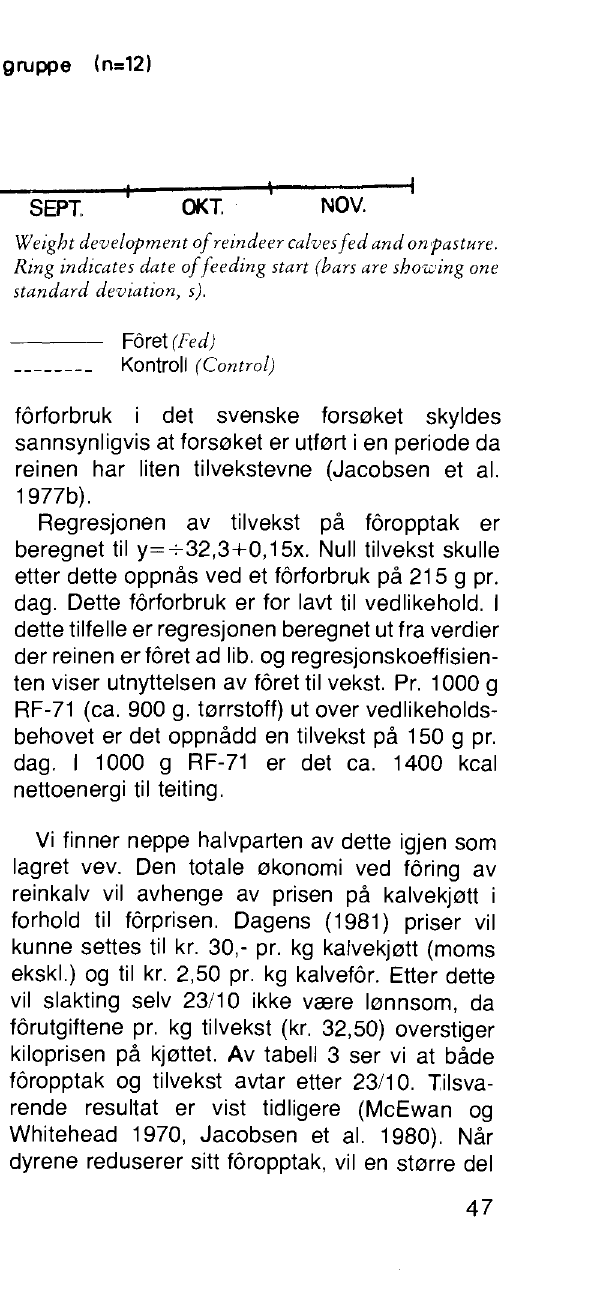
Figur 1. Vektutvikling av forede reinkalver og reinkalver på beite. Ring angir start av foringen (stolpene viser ett standardavvik,